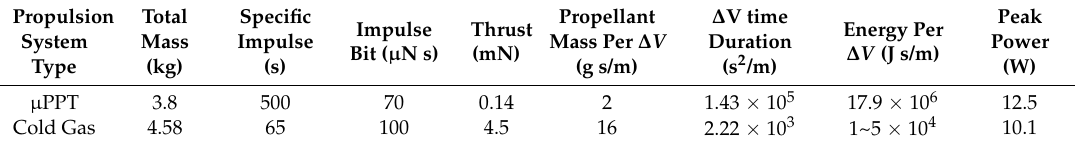
Table 24. Comparison of typical Cold Gas Thruster and Pulsed Plasma Thrusters